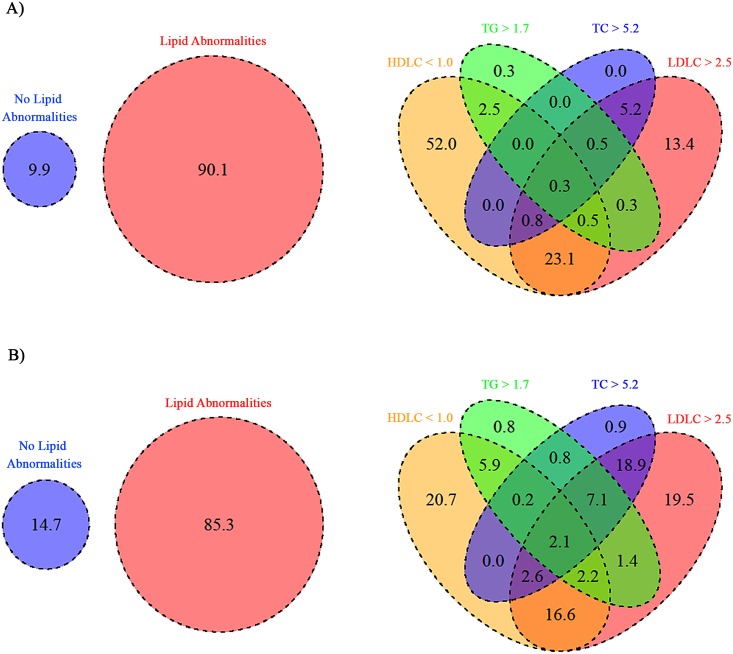
Distribution of lipid abnormalities in treatment naïve (A) and participants receiving ART (B).The left-sided Venn diagrams indicate % with dyslipidaemia. The right-sided diagrams indicate the individual lipid abnormalities in dyslipidaemic participants. Percentages in the right diagrams refer to % dyslipidaemic participants. Rounding accounts for percentages not equal to 100.